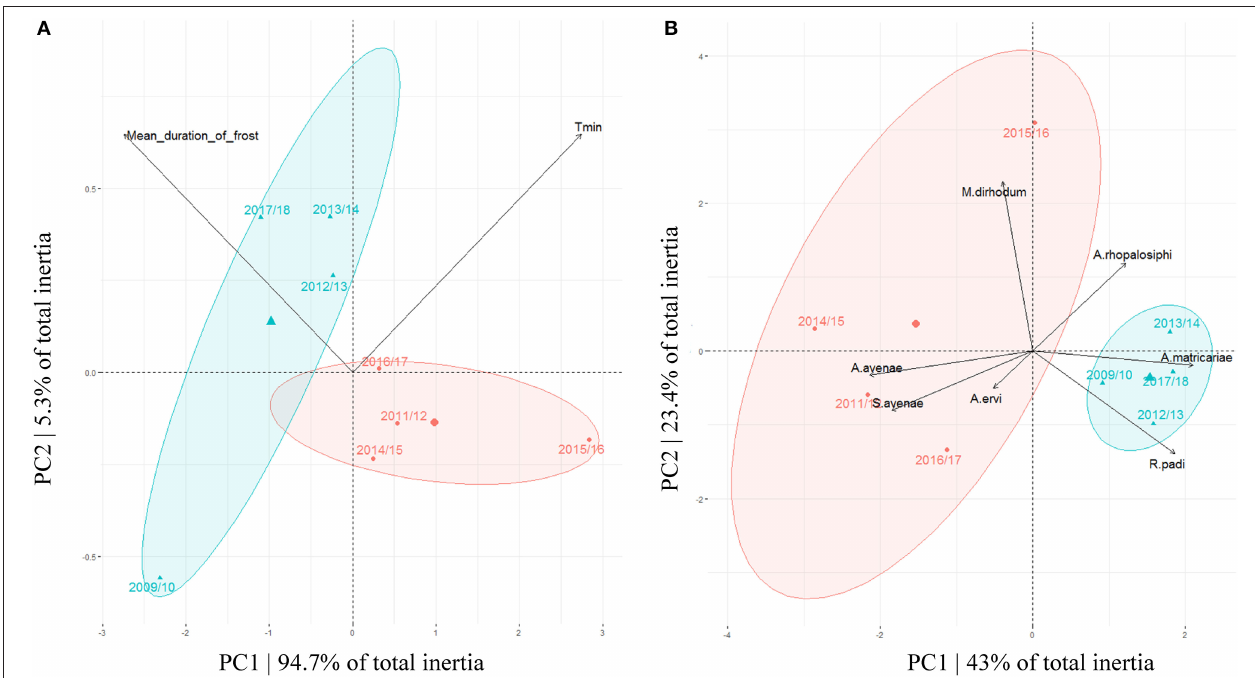
FIGURE 2 | (A) PCA partitioning two climatic variables (mean minimal temperatures “Tmin” and mean duration of frost events) by sampling years. (B) PCA partitioning aphid and parasitoid species relative abundances by sampling years. Confidence ellipses are constructed around groups of cold (blue) and mild (red) winters.